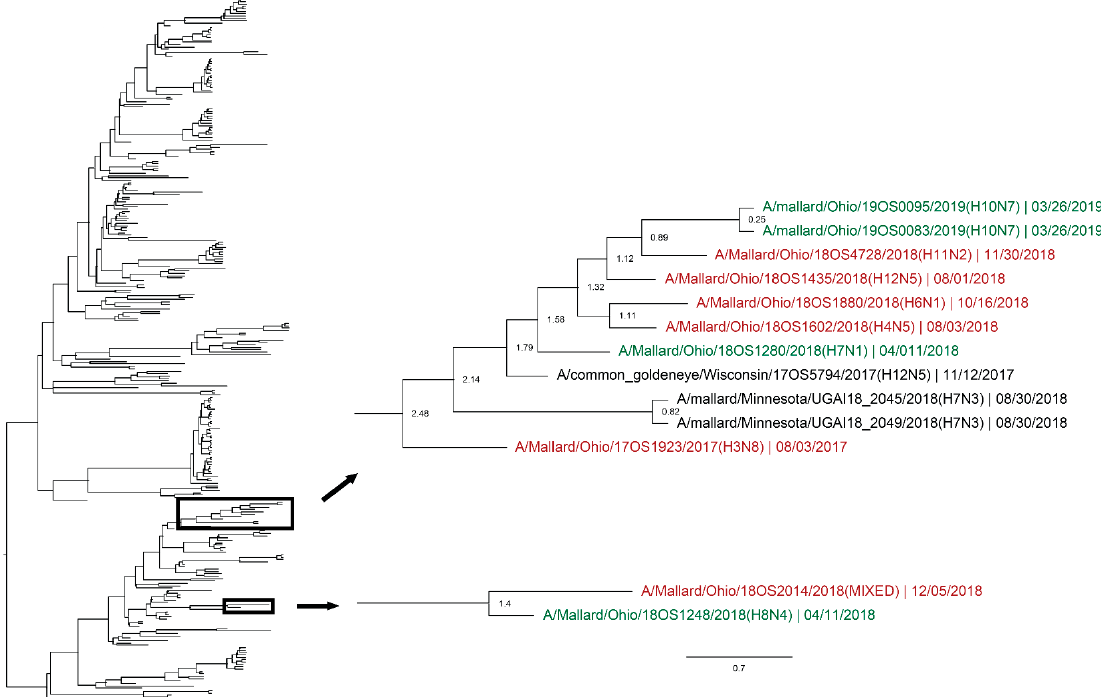
Figure 4. Maximum clade credibility tree of the PA gene segment. Active influenza A virus surveillance was conducted year-round in wild mallards ( Anas platyrhynchos ) in one location over two years. Time-stamped phylogenetic analysis with a general time reversible plus gamma substitution model revealed genetic persistence across multiple seasons, including the historically under-sampled spring season, in the relatively conserved PA gene segment. Highly supported clades ( > 0.95 posterior probability) containing viruses detected in the spring (green) who share a common ancestor with viruses detected in another season (red) throughout the study period with a time to most recent common ancestor of < 2.5 years are highlighted. Node ages are indicated. Scale bar represents time in